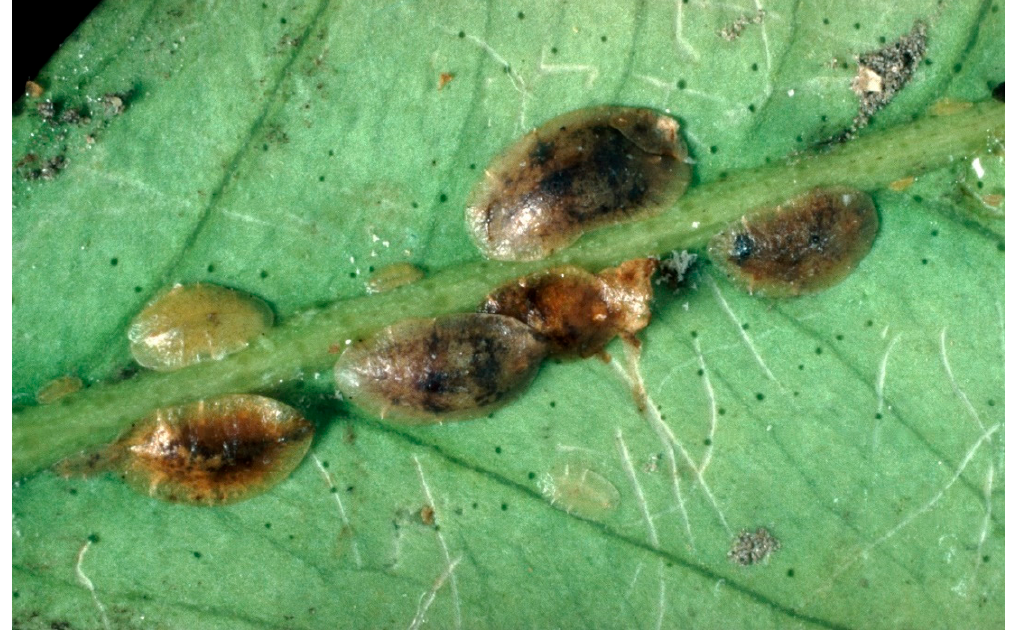
Figure 2. Female and juvenile brown soft scales ( Coccus hesperidum ) on the underside of a leaf.